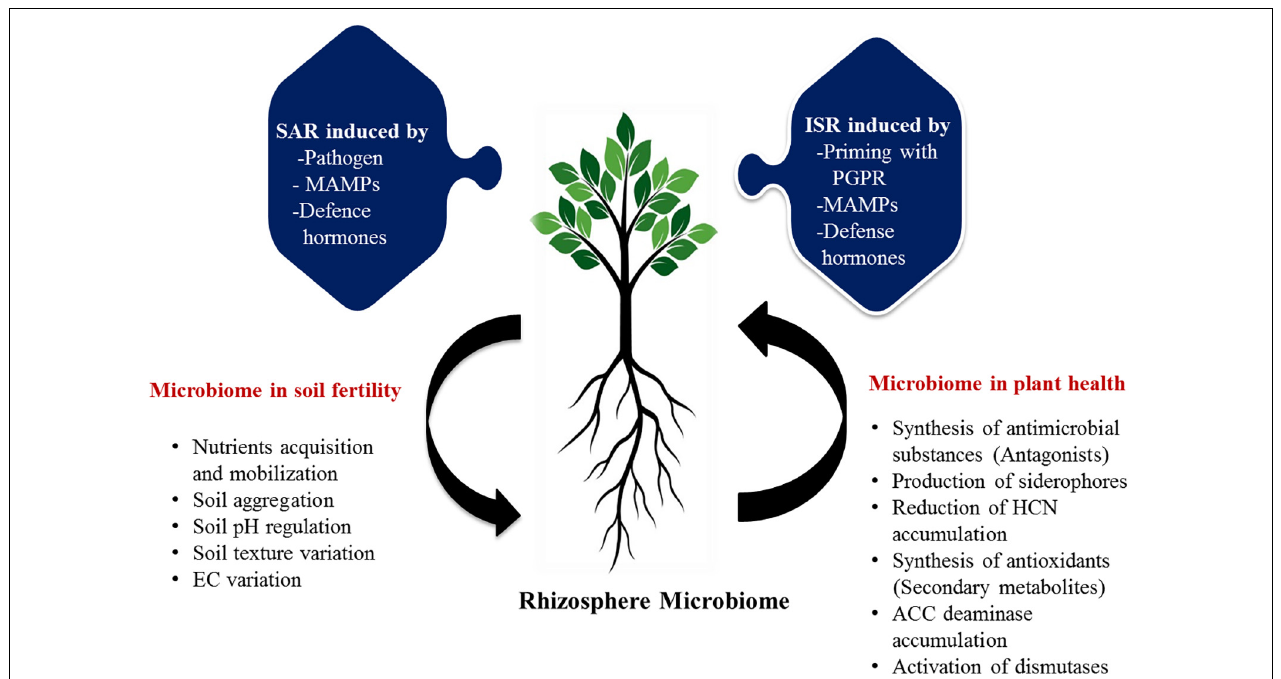
FIGURE 3 | The proposed possible roles of rhizosphere microbiome in soil and plant health of citrus. Functional traits of microbiota in the management of soil and plant health are represented in various mode of action. ISR, induced systemic resistance; SAR, systemic acquired resistance; PGPR, plant growth promoting rhizobacteria; MAMPs, microbe-associated molecular pattern; EC, electrical conductivity; HCN, hydrogen cyanide; ACC, 1-aminocyclopropane-1-carboxylic